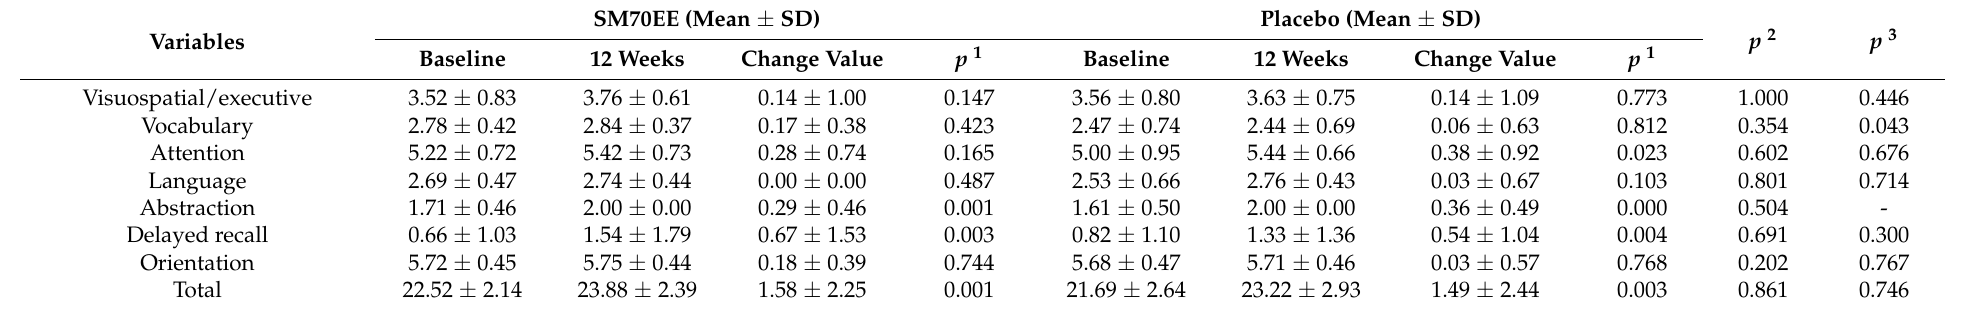
Table 4. Changes in the Korean version of the Montreal Cognitive Assessment (MoCA-K) test before and after 12 weeks of SM70EE product consumption (excluding outliers).